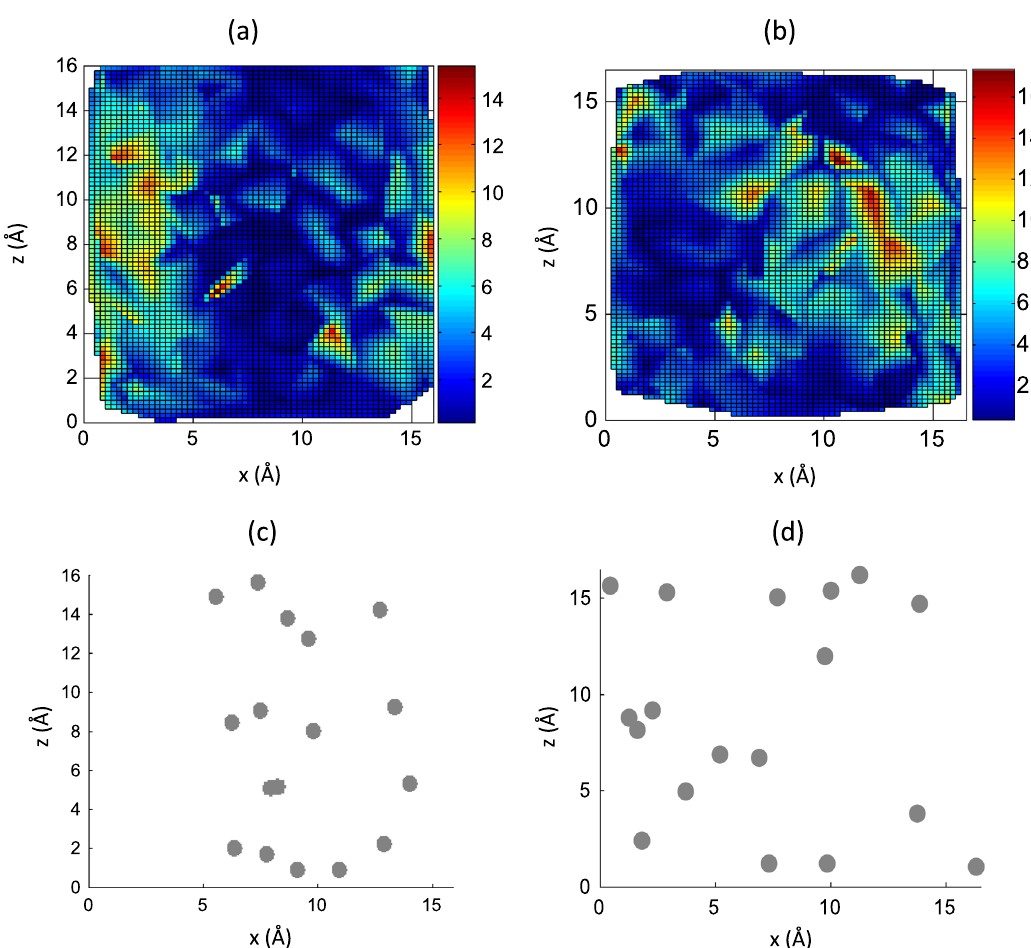
Fig. 11 Propensity map of all atoms in the simulation box for a Al − Cr binary alloy at T = 800 K, b Al − Zn − Cr ternary alloy T = 800 K. The color scale corresponds to the propensity in Angstrom squared. Positions of the Cr atoms in the initial con fi guration of the isocon fi gurational simulations c Al − Cr binary alloy at T = 800 K. d Al − Zn − Cr ternary alloy T = 800 K. Panels a and c are drawn from ref. 24 by permission of the American Physical